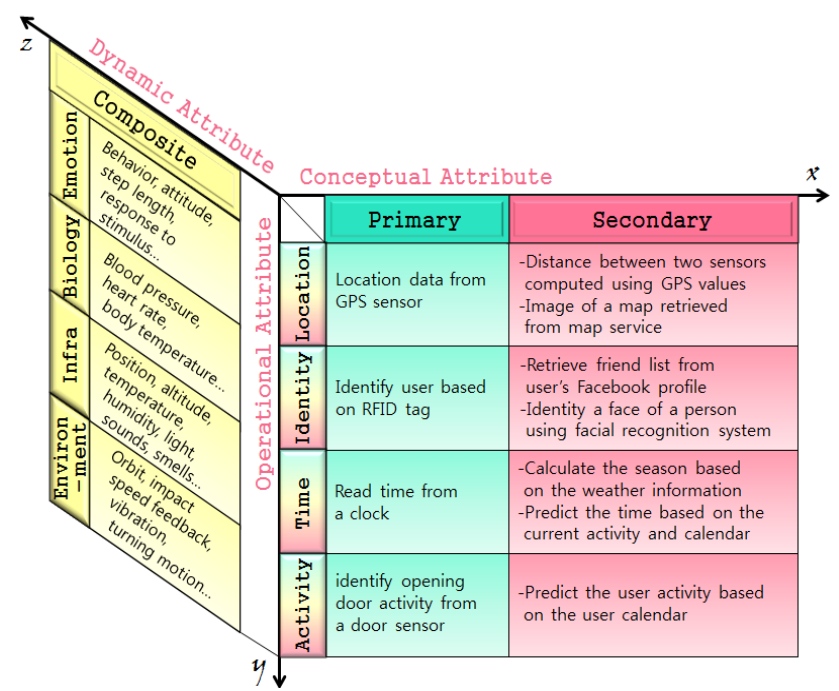
Figure 2. Three-dimensional context classification scheme.